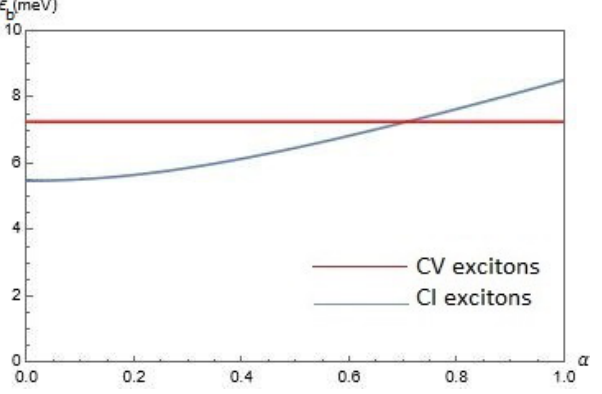
Figure 3. The exciton binding energy E b ( α , ∆ , D ) for CV and CI excitons as functions of the parameter α for chosen gap ∆ = 0.5 ¯ hv F / a and interlayer separations D = 25 nm.